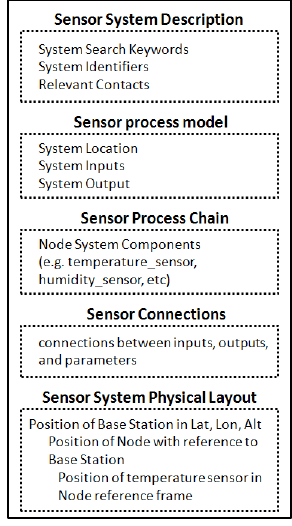
Figure 4. Outline of SensorML GeoSense